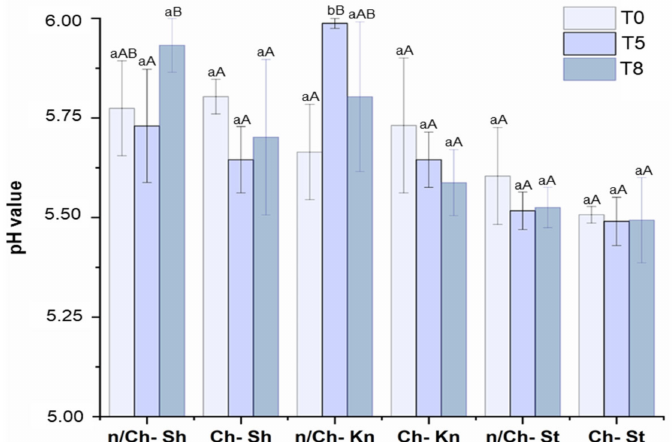
Figure 5. pH values of vacuum-packed non-coated and coated beef cuts samples over the storage period of 0 (T0), 5 (T5) and 8 (T8) days at 4 ◦ C. n/Ch–Sh = non-coated shoulder; Ch–Sh = coated shoulder; n/Ch–St = non-coated striploin; Ch–St = coated striploin; n/Ch–Kn = non-coated knuckle; Ch–Kn = coated knuckle. Columns represent the mean ( n = 3), and the bars represent the standard deviation. a,b Different lowercase letters show significant differences ( p < 0.05) between the same beef cut with different treatments on the same storage day. A,B Different uppercase letters indicate significant differences ( p < 0.05) for the same beef cut sample over the storage period (T0, T5 and